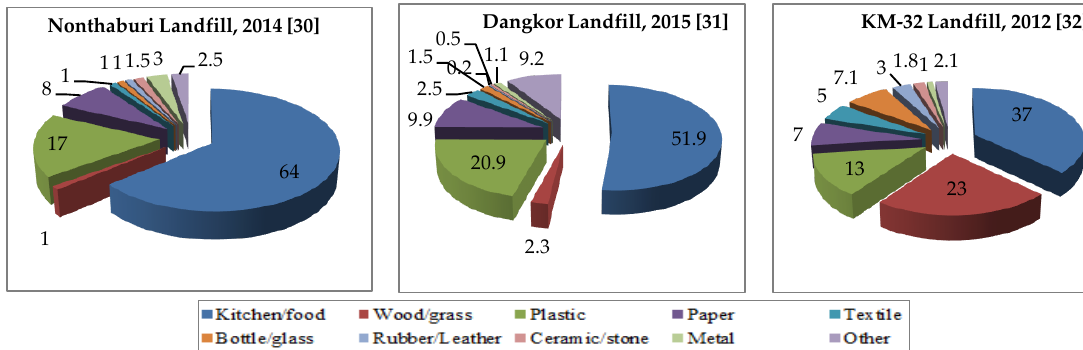
Figure 2. Waste composition in percent (%).